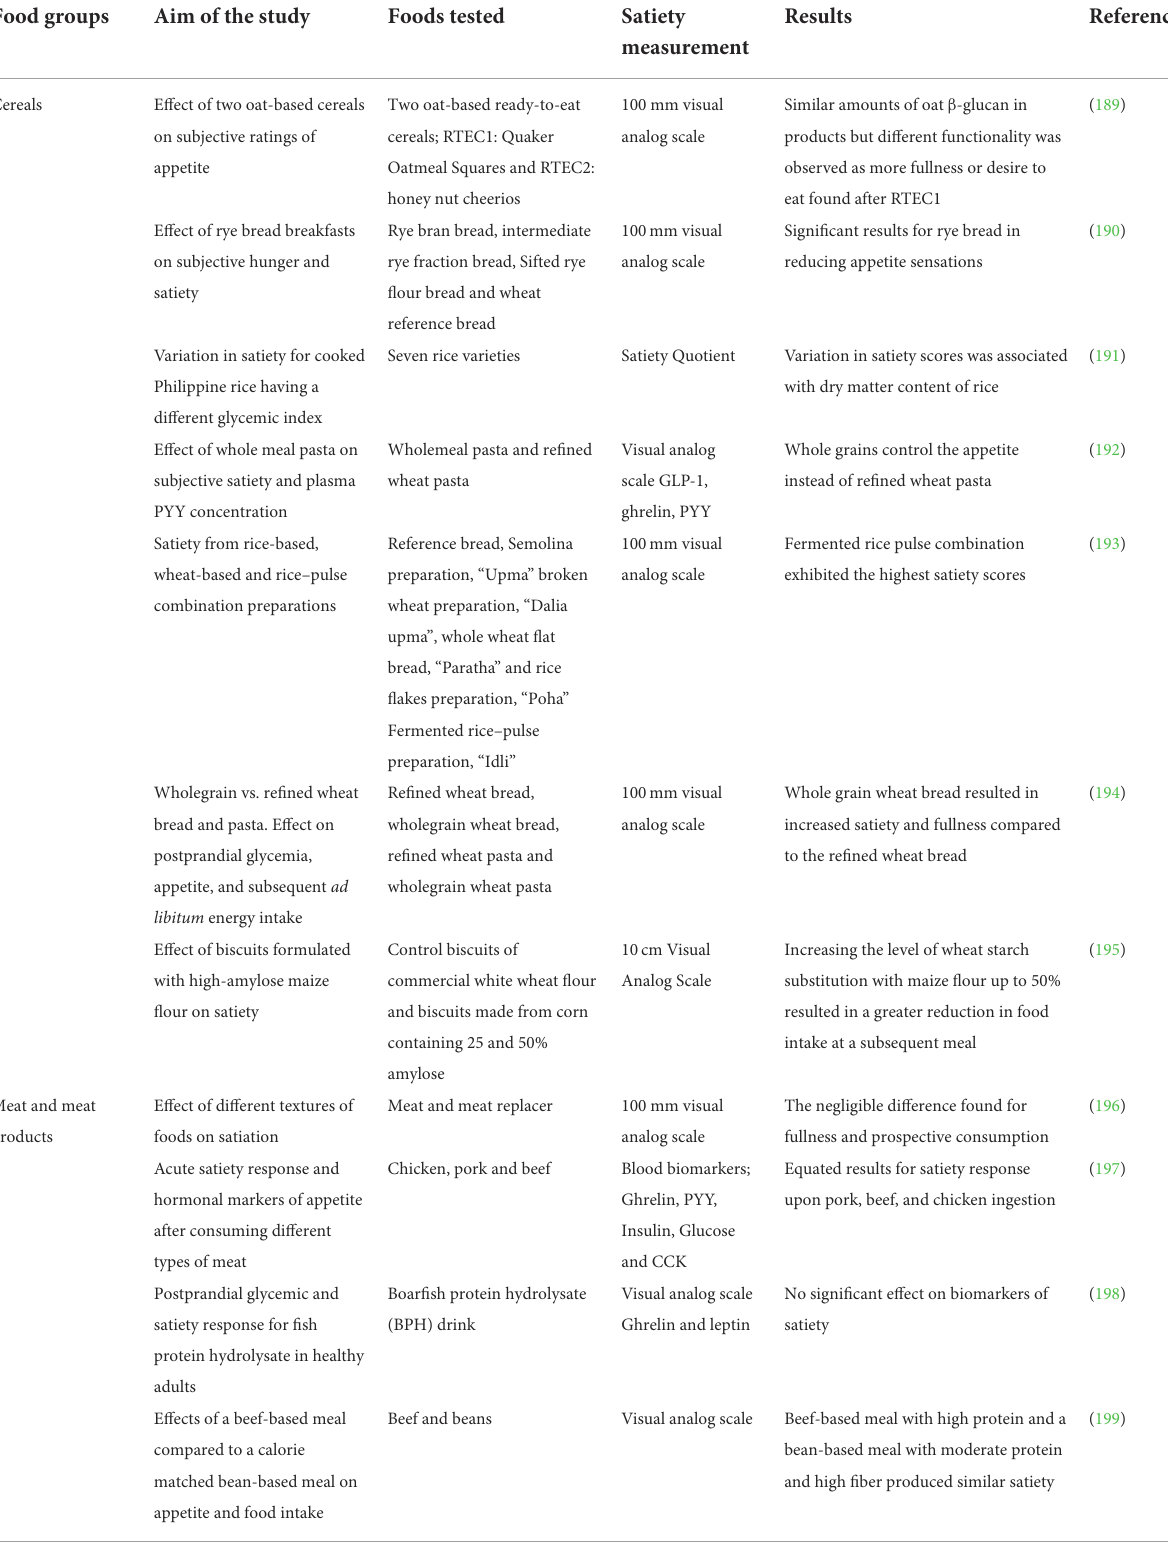
TABLE 1 Summarizing results of studies assessing variation in satiety among food